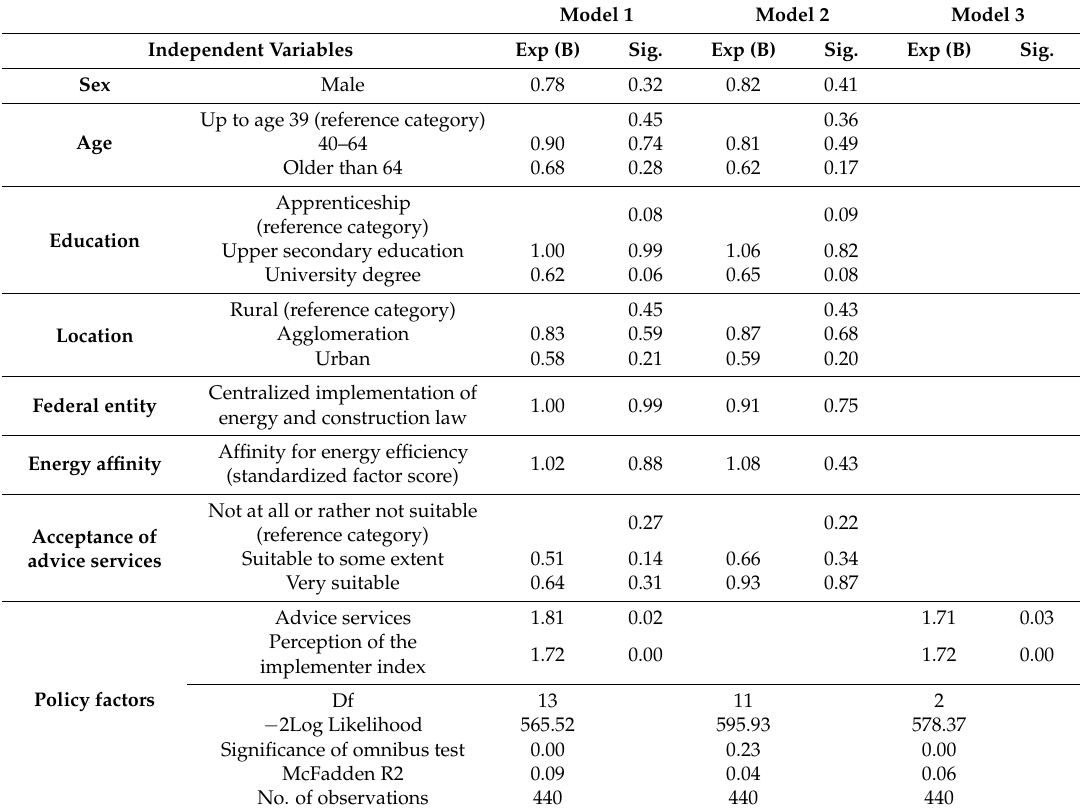
Table 3. Effects on the effectiveness of subsidies beyond free riding. EXP (B)—odds ratio. Sig.—significance level.